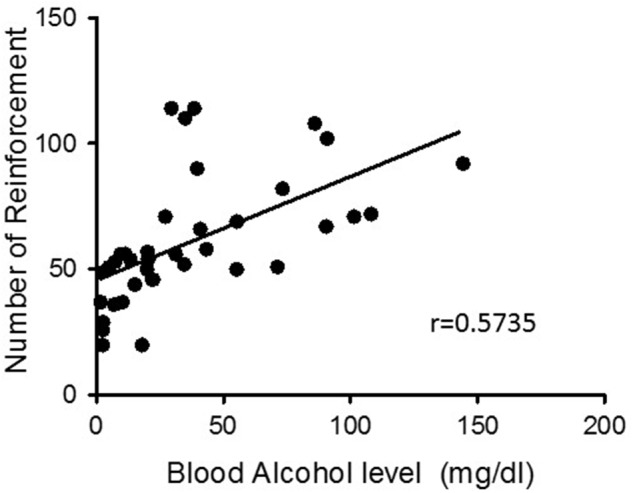
Blood ethanol determination. Immediately after the end of the last VI-30 session, blood samples (50 μl) were collected from the tip of the tail of each rat. The graph depicts the correlation plots of the number of reinforcements achieved during the last training session as a function of the blood ethanol level (p < 0.01).